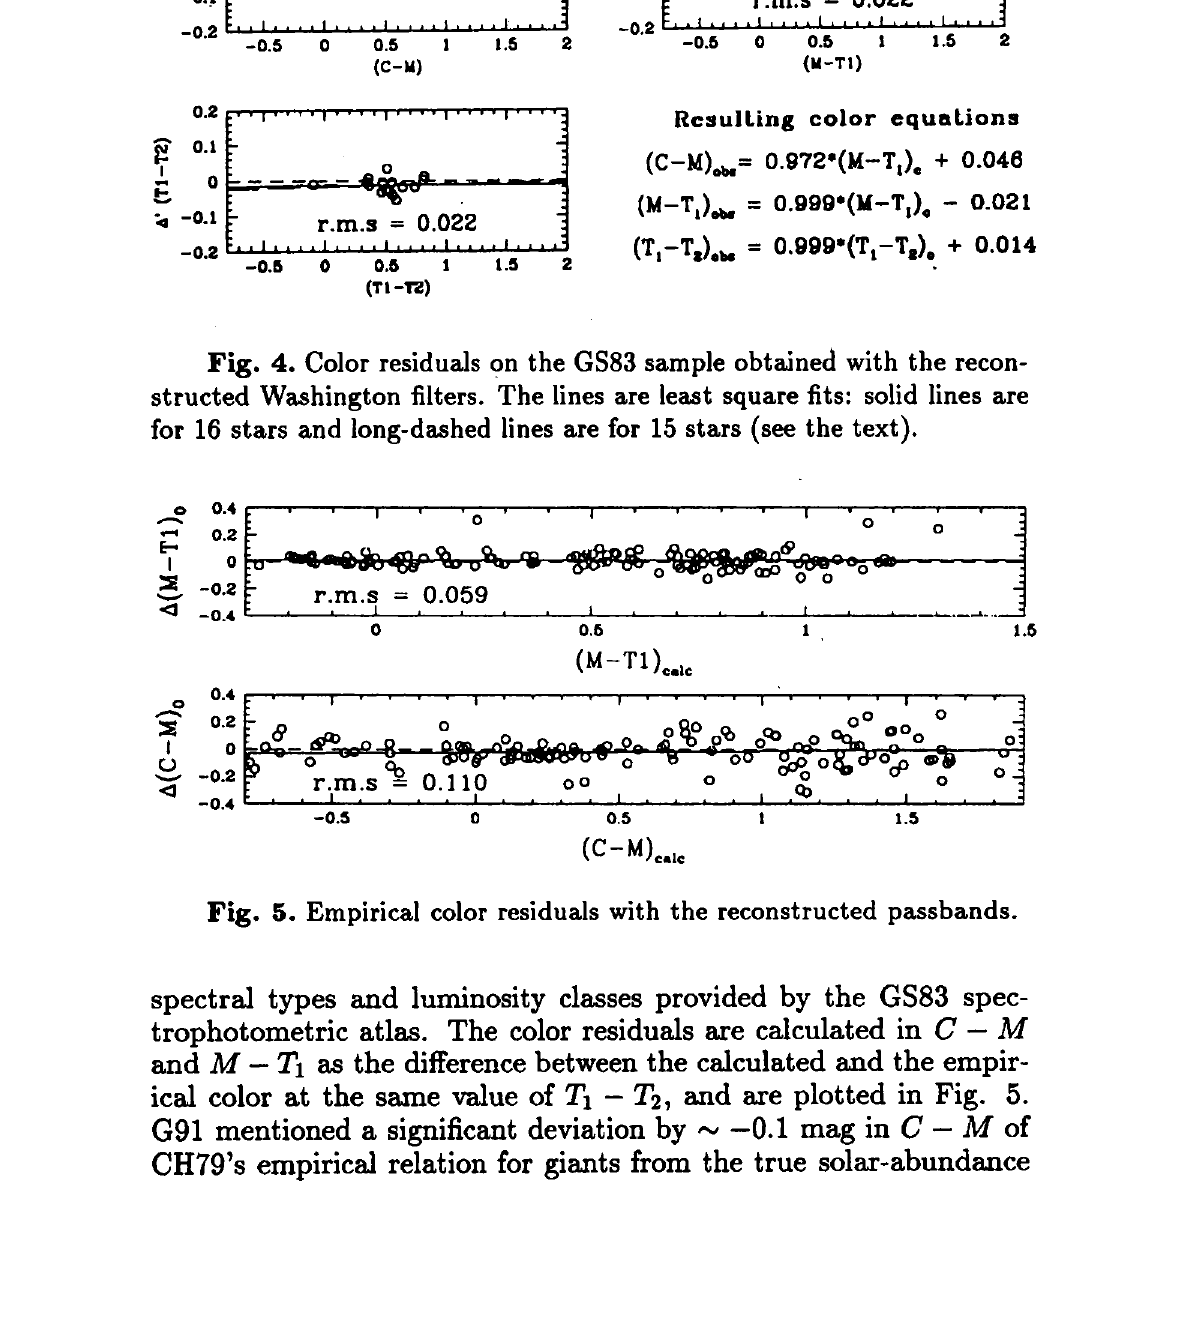
Fig. 5. Empirical color residuals with the reconstructed